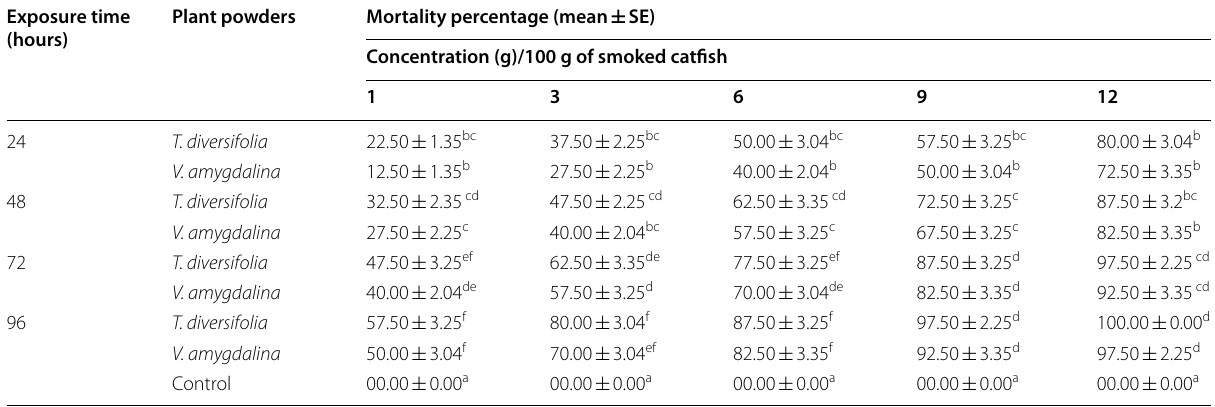
Mean followed by the same letters within the same column are not significantly different ( P >0.05)